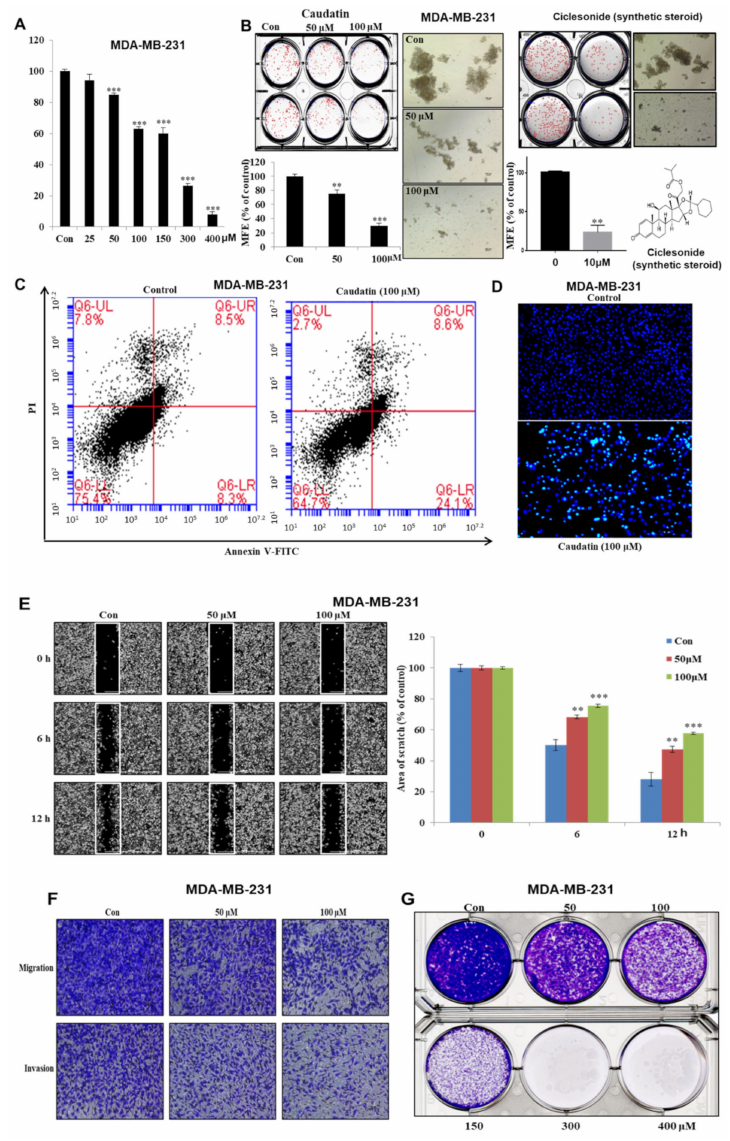
Figure 3. The e ff ects of caudatin on the proliferation and mammosphere formation of breast cancer cells. ( A ) MDA-MB-231 cells were cultured in a 96-well plate with caudatin for 24 h. MDA-MB-231 cell proliferation was assayed with an EZ-Cytox kit. ( B ) Caudatin and ciclesonide reduced mammosphere formation by breast cancer cells. Mammospheres derived from MDA-MB-231 cells were cultured in ultralow-attachment 6-well plates with CSC culture medium for seven days. The mammosphere formation e ffi ciency (MFE) was examined with increasing concentrations of caudatin and ciclesonide. Images show representative mammospheres and were obtained by microscopy (scale bar: 100 µ m). ( C ) Caudatin induced apoptosis in MDA-MB-231 cells. Apoptosis was determined using Annexin V / propidium iodide (PI) staining. ( D ) Apoptotic cells induced by caudatin were stained with Hoechst 33,342 dye (scale bar: 50 µ m). ( E ) The migration of MDA-MB-231 cells with / without caudatin (Dulbecco’s Modified Eagle’s medium (DMEM) / 0.5% fetal bovine serum (FBS)) was imaged at 0, 6 h and 12 h by a scratch assay (scale bar: 100 µ m). The percent of inhibition in cell migration was expressed using untreated well at 100%. ( F ) The cell migration (without Matrigel) and invasion (with Matrigel) of MDA-MB-231 cells exposed to caudatin were determined by transwell assays (scale bar: 100 µ m). ( G ) MDA-MB-231 cells were incubated in 6-well plates and treated with caudatin. Representative colony formation data were collected. The data from triplicate experiments are represented as the mean ± SD. ** p < 0.01 and *** p < 0.001 versus the DMSO-treated control